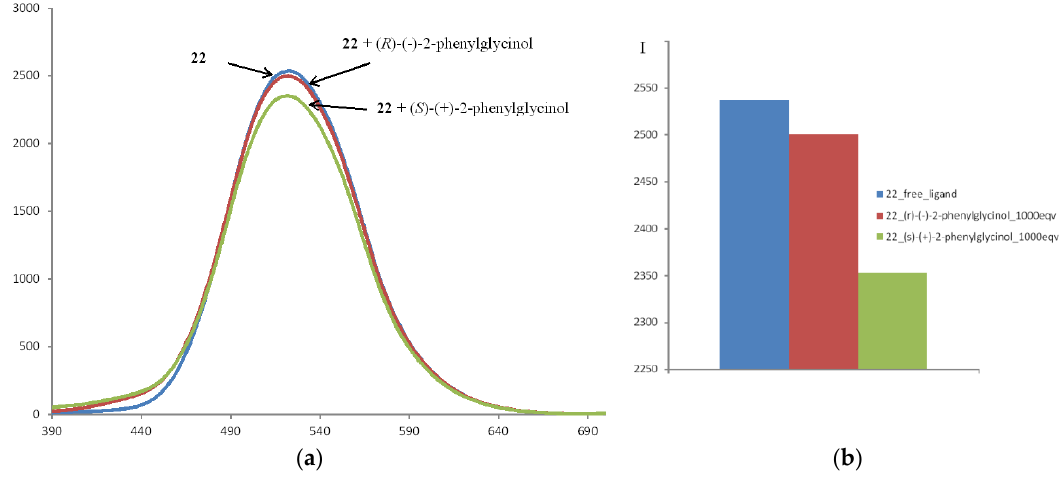
Figure 9. Fluorescence spectra of compound 22 in the presence of ( R )- and ( S )-enantiomers of 2-phenylglycinol (1000 equiv.); ( a ) general view; ( b ) schematic representation of the changes in emission.